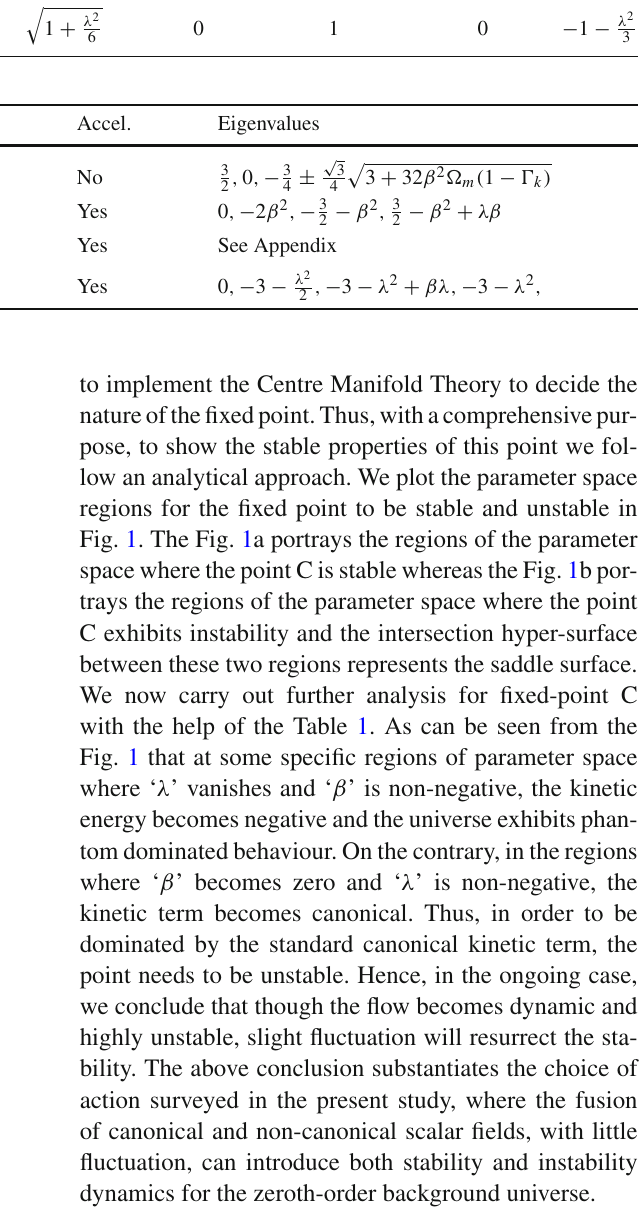
Table 1 The critical points and cosmological parameters corresponding to an autonomous system of an interacting DE–DM model with an exponential potential and constant α